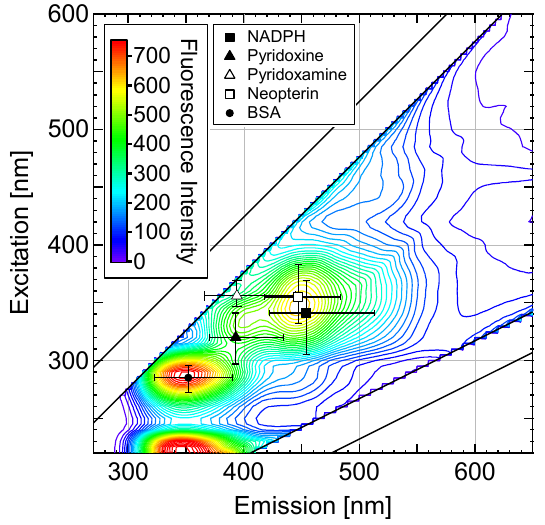
Fig. 4. EEM contour profile for Saccharomyces cerevisiae (baker’s yeast). Spectral positions of selected pure fluorophores are shown for comparison. BSA is chosen as a general proxy for